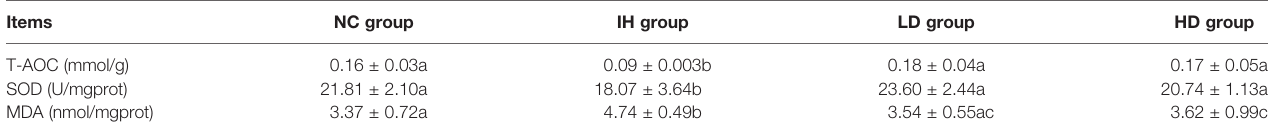
TABLE 2 | Effects of supplementary 1% and 2% of crude lentinan (CLNT) on intestinal antioxidant ability in infectious hematopoietic necrosis virus (IHNV) – infected rainbow trout. Items